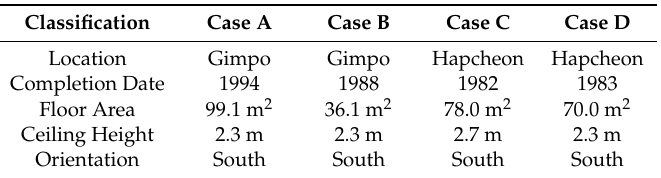
Table 3. Overview of the studied buildings.